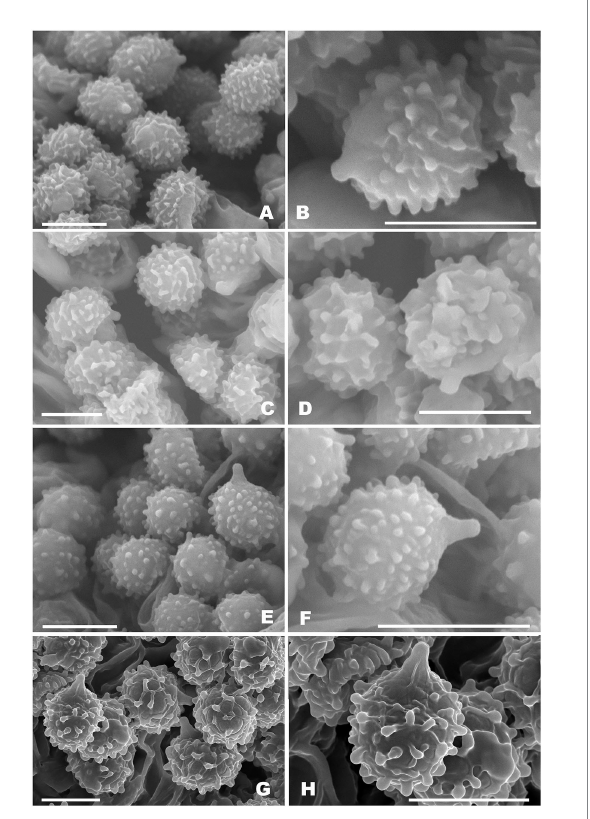
FIGURE 3 Basidiospores of Russul a subg. Heterophyllidiae species from herbarium materials under SEM. (A,B) Russula discoidea (FHMU4847, holotype); (C,D) Russula niveopicta (FHMU958, holotype); (E,F) R. subatropurpurea (FHMU5454); (G,H) R. xanthovirens (FHMU1986); scale bars = 5 μ m; photographs: Y. X.